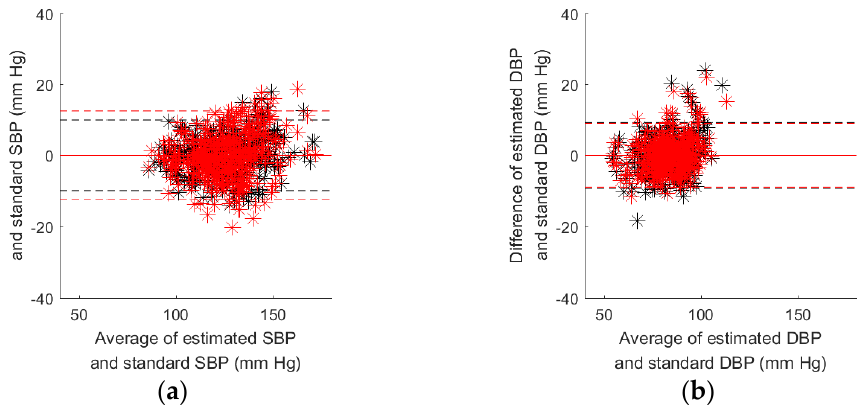
Figure 6. ( a ) Bland–Altman plot of estimated SBPs by reference (black) and proposed (red) methods with Equation (4), and the standard SBP; ( b ) Bland–Altman plot of estimated DBPs by the reference (black) and proposed (red) methods with Equation (4), and the standard SBP. Table 5. The results of estimated systolic and diastolic blood pressures with Equation (4).